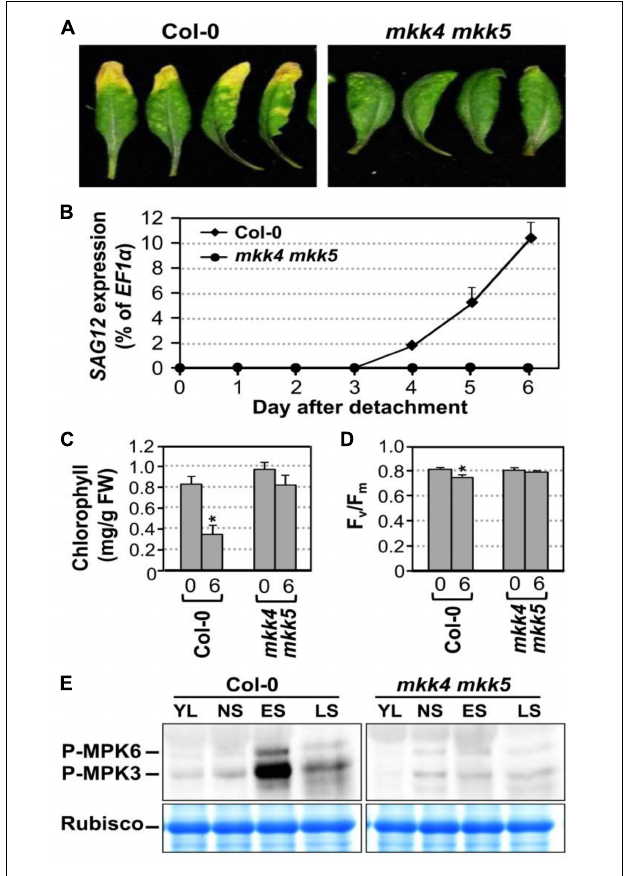
FIGURE 3 | MKK4 and MKK5 play redundant function in leaf senescence. (A) Leaf senescence phenotype of detached leaves of wild type and mkk4 mkk5 double mutants. Fully expanded leaves from 4-week-old soil-grown plants were detached and their petioles were inserted to 0.6% agar medium under continuous light. Photos were taken 6 days after detachment. (B) RT-qPCR analysis of the transcript levels of SAG12 in wild type and mkk4 mkk5 double mutants at indicated times. The expression of EF1 α was used as an internal reference. Values are means ± SD, n = 3. (C,D) Quantitative analysis of chlorophyll contents (C) and F v /F m (D) in leaves shown in (A) . Values are means ± SD, n = 10. (E) Phosphorylation/activation of MPK3/MPK6 induced by age-dependent leaf senescence was detected by immunoblot analysis using anti-pTEpY antibody (upper). Equal loading of proteins was confirmed by Coomassie brilliant blue staining of Rubisco (lower). YL, young leaves; NS, fully expanded no senescence mature leaves; ES, early senescence leaves, with < 25% leaf yellowing; LS, lately senescence leaves, with > 50% leaf yellowing (please also see Figure 5A ). Asterisks indicate a significant difference (P ≤